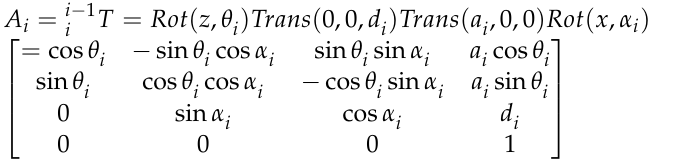
Table 1. Robot linkage and geometric